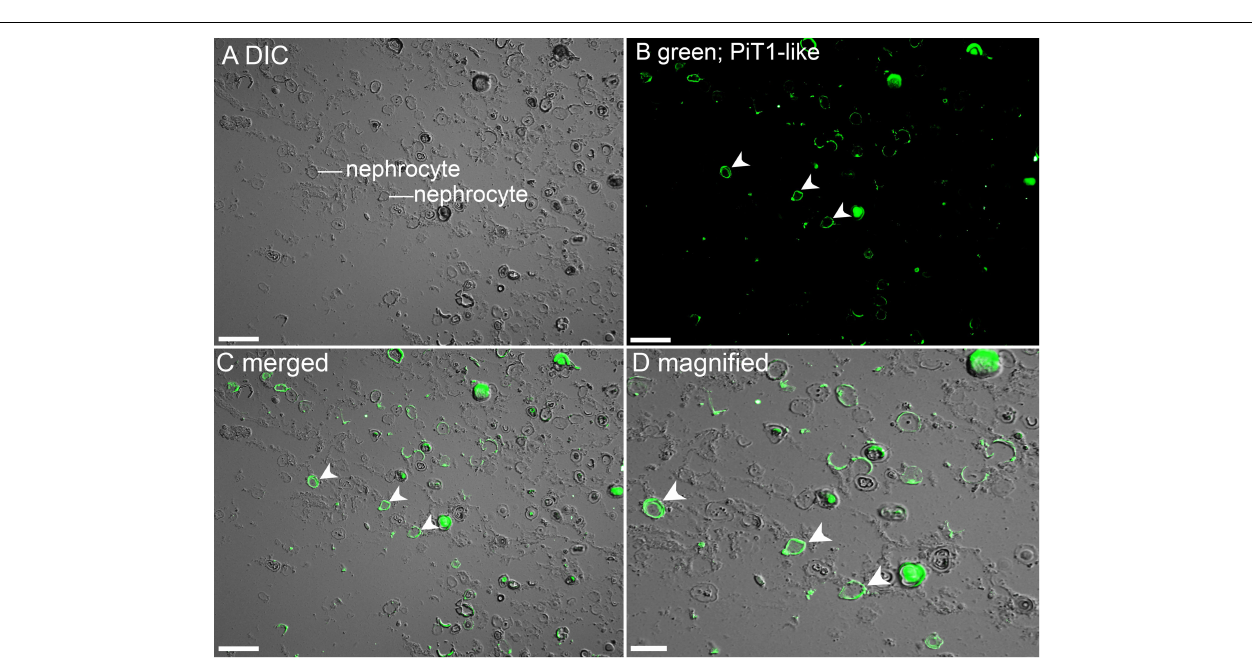
FIGURE 4 | Immunofluorescence localization of a homolog of sodium-dependent phosphate transporter protein 1 (PiT1-like) in the kidney of Tridacna squamosa exposed to 12 h of light. (A) Differential interference contrast (DIC) image to demonstrate the histological structure of kidney nephrocytes. (B) Green immunofluorescence staining of the membrane of kidney nephrocytes (labeled with arrowheads) indicates presence of PiT1-like protein. (C) Merged images of DIC with PiT1-like labeling with (D) a magnified view. Scale bar: (A–C) , 50 µ m; (D) , 20 µ